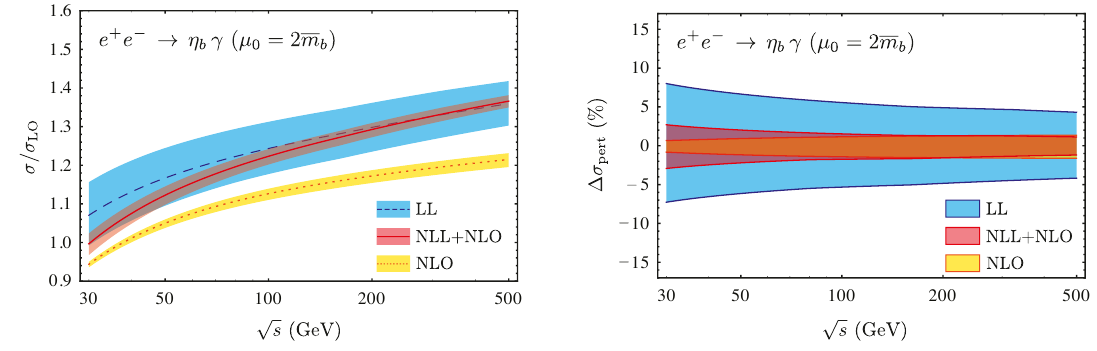
Figure 3 . Left panel: LL, NLL+NLO and NLO cross sections normalized by LO cross section with (cid:22) 0 = 2 m b . right panel: corresponding perturbative uncertainties in percentage. q (cid:14)(cid:27) 2 + (cid:14)(cid:27) 2 + (cid:14)(cid:27) 2 , where (cid:14)(cid:27) is the change of cross section by a scale variation of (cid:22) (cid:22) i (cid:22) 0 (cid:22) (cid:22) ns